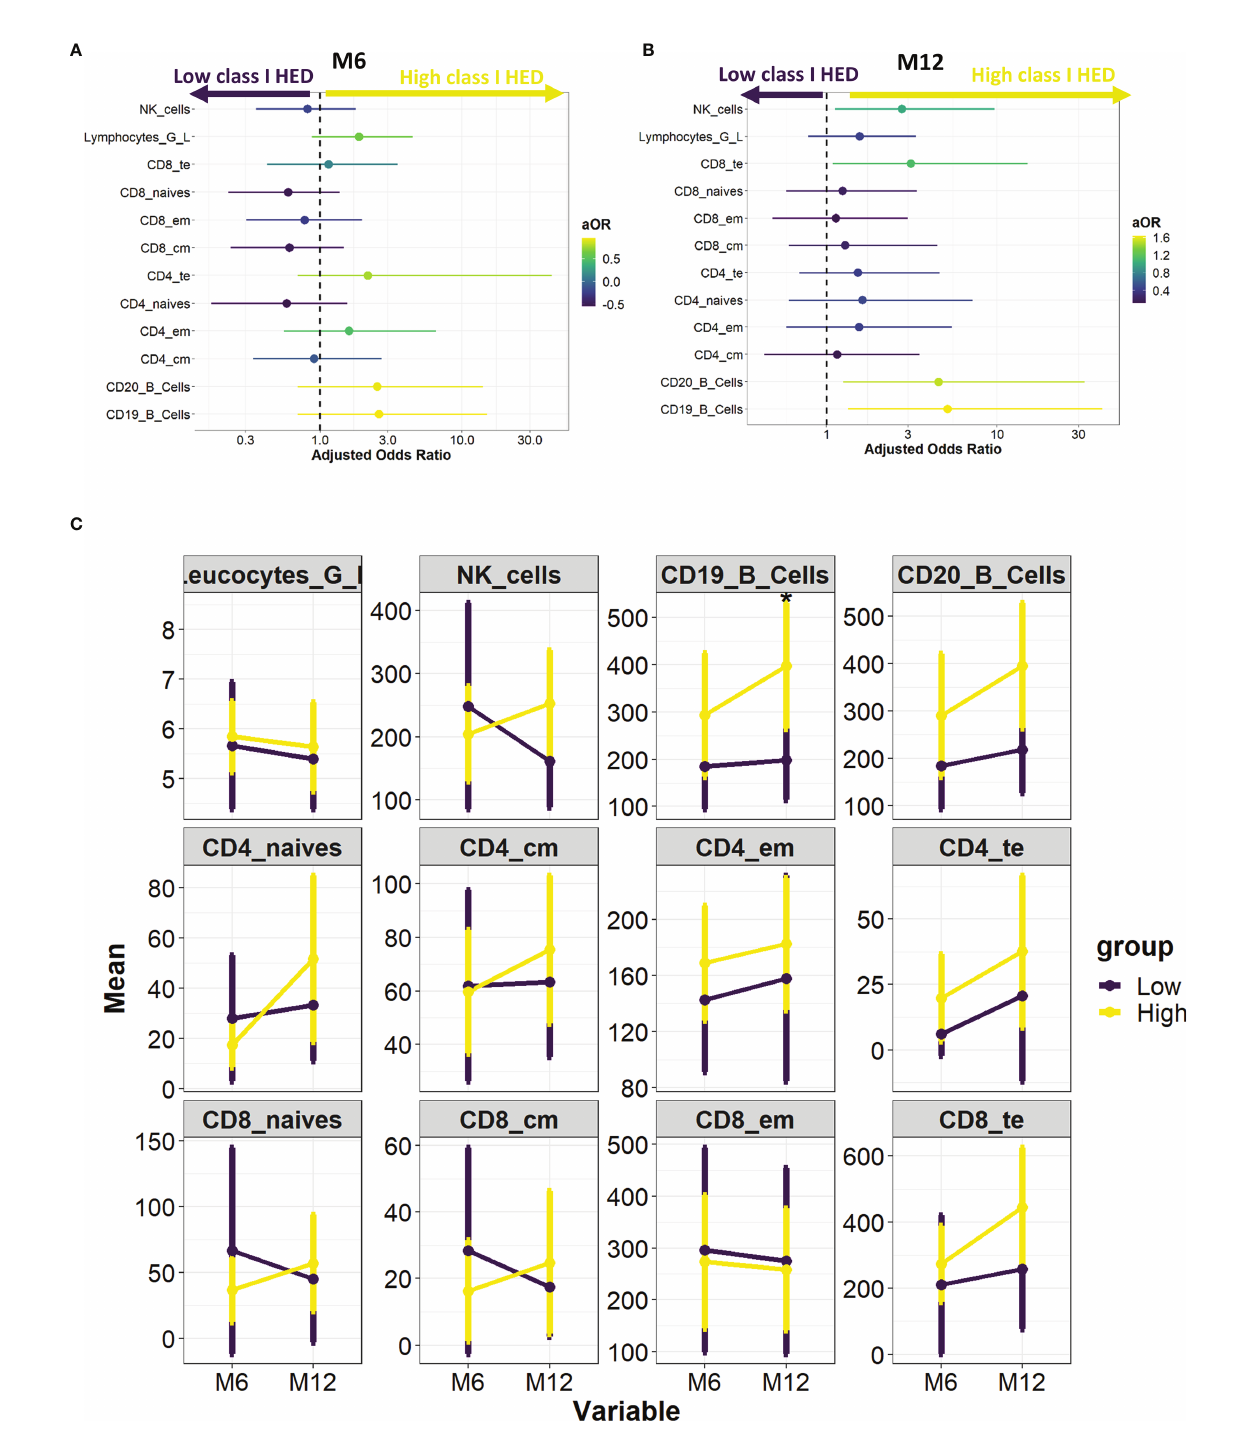
FIGURE 4 | HED impact on immune reconstitution at 6 and 12 months post-HCT. (A) Association between high versus low median class I HED and lymphocyte subset recovery at 6 months. Odds Ratio were calculated using a multivariate logistic regression model controlling for HLA matching and conditioning. (B) Association between high versus low median class I HED and lymphocyte subset recovery at 12 months. Odds Ratio were calculated using a multivariate logistic regression model controlling for HLA matching and conditioning. (C) Evolution of total leucocyte and lymphocyte subset counts according to median class I HED at 6 and 12 months post-HCT. CM, central memory; EM, effector memory, HCT, hematopoietic cell transplantation; HED, HLA evolutionary divergence; NK, natural killer; TE, terminal